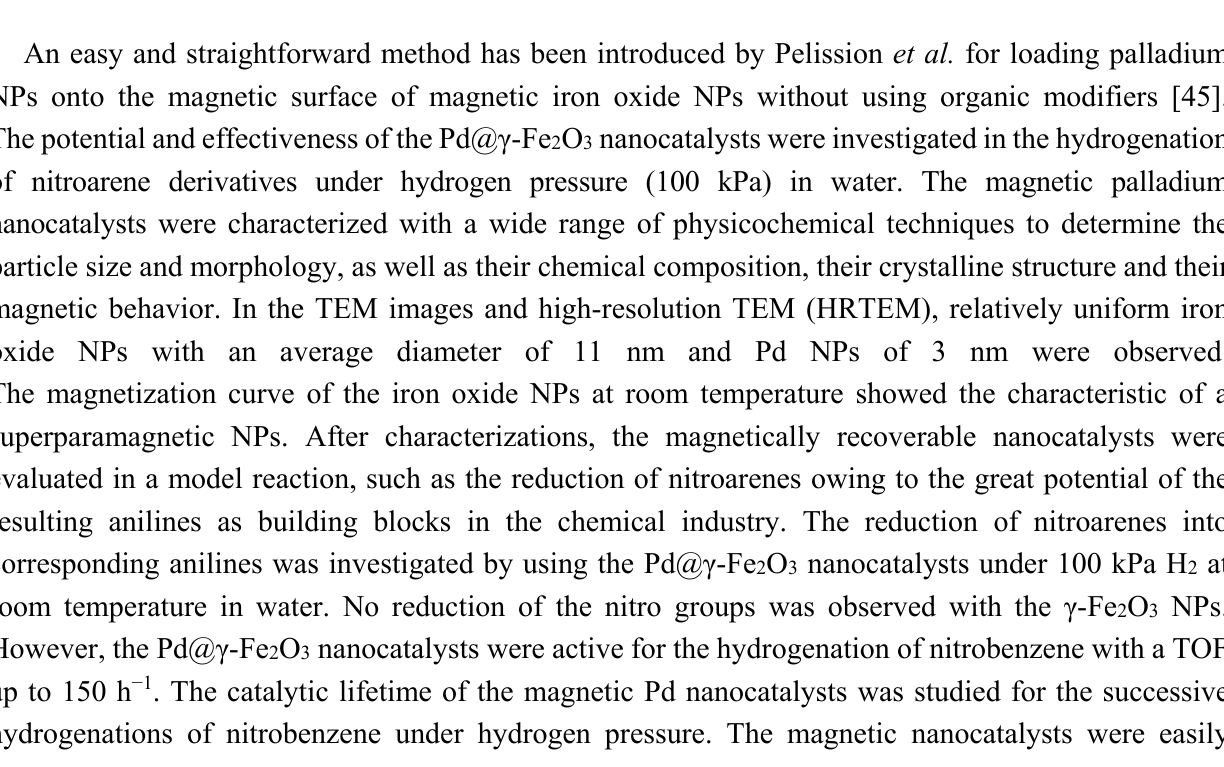
Figure 2. Reusability of the magnetic Au nanocatalysts in the reduction of